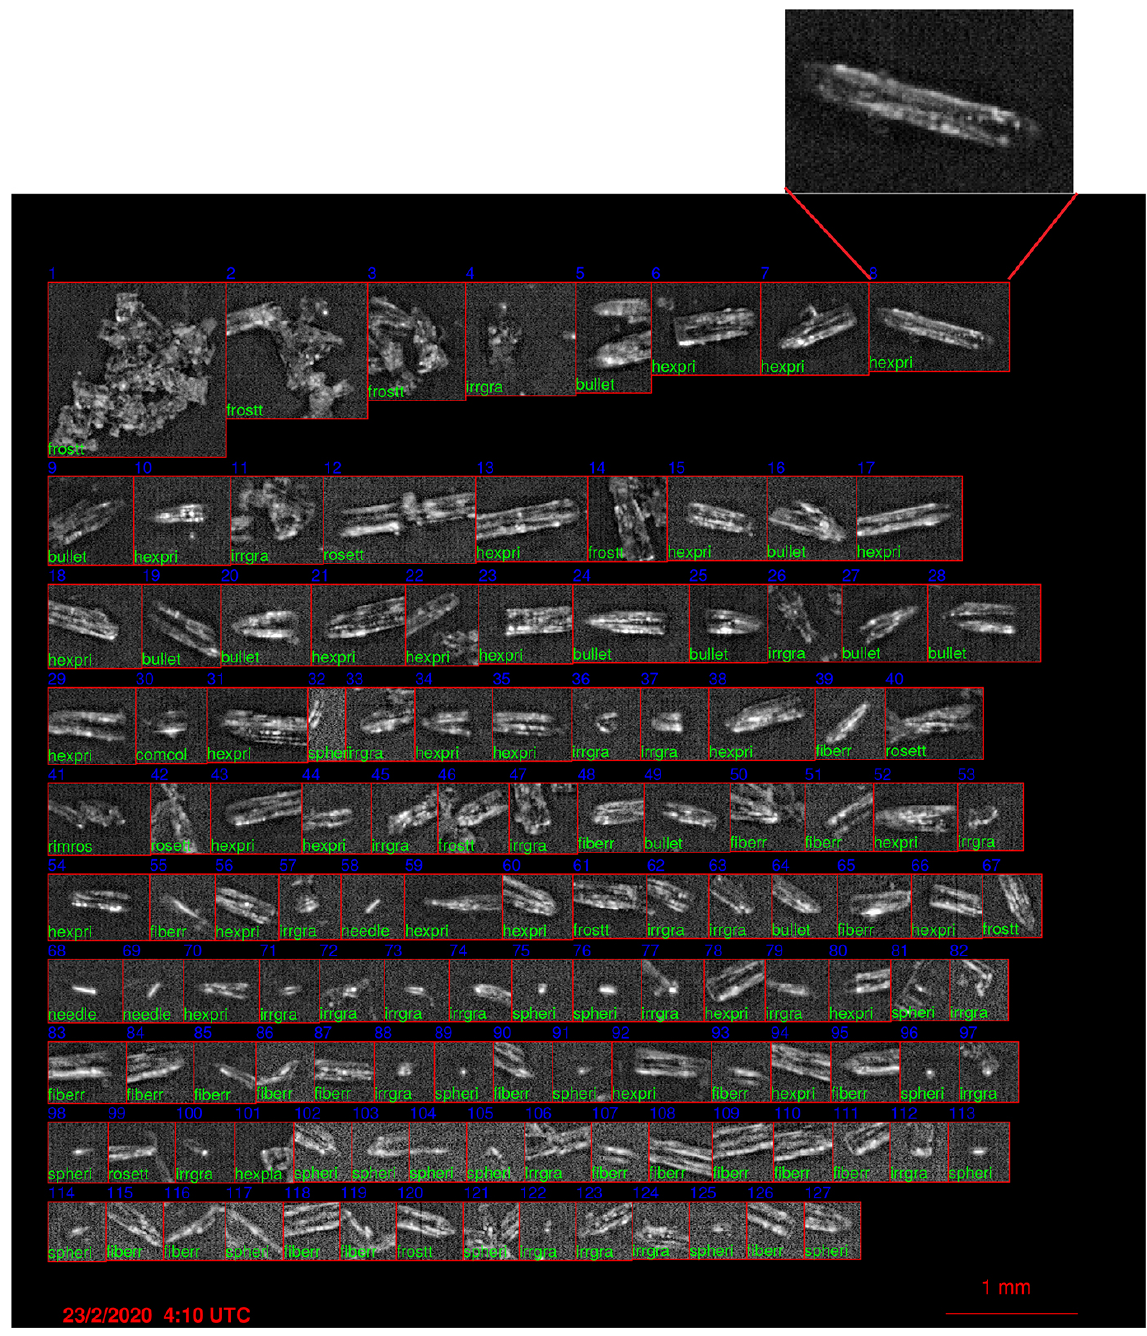
Figure 19. ICE-CAMERA photographs for the day of 23 February at 04:10UTC. The photograph indicates the presence of mostly hexagonal columns. In the upper part is the zoom of a single column